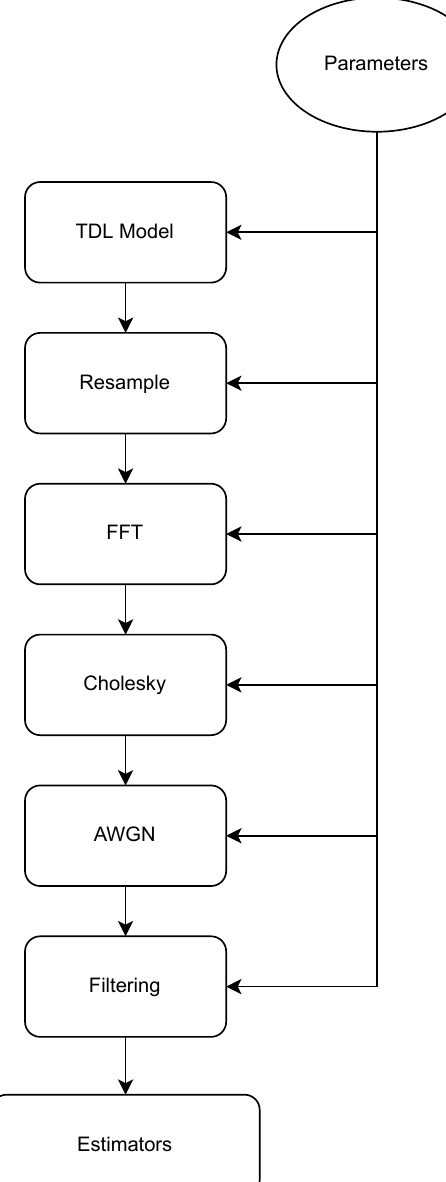
Figure 2. Diagram of the